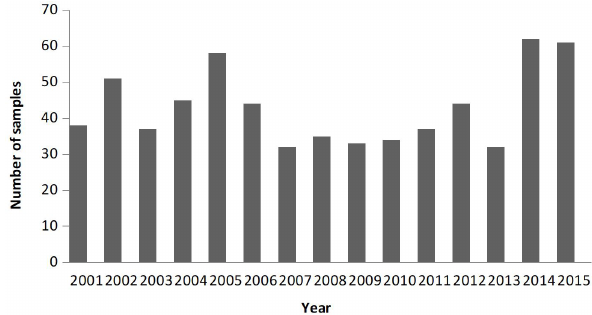
Figure 1. Brain samples received at the Zoonosis Diagnostic Service – SDZ, between 2001 and 2015, from cattle and